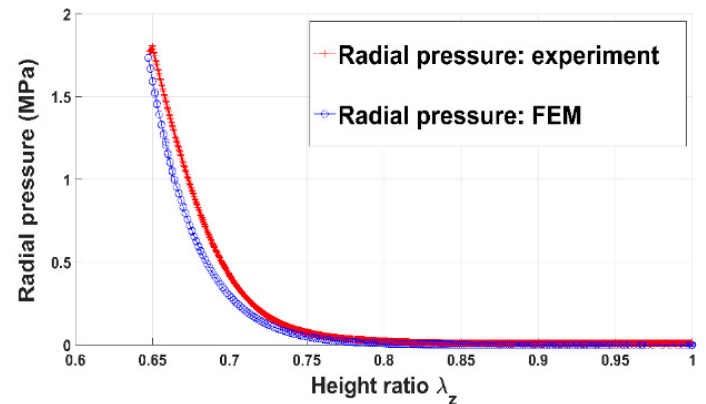
Figure 17. Axial pressure: FEM vs. experiment.